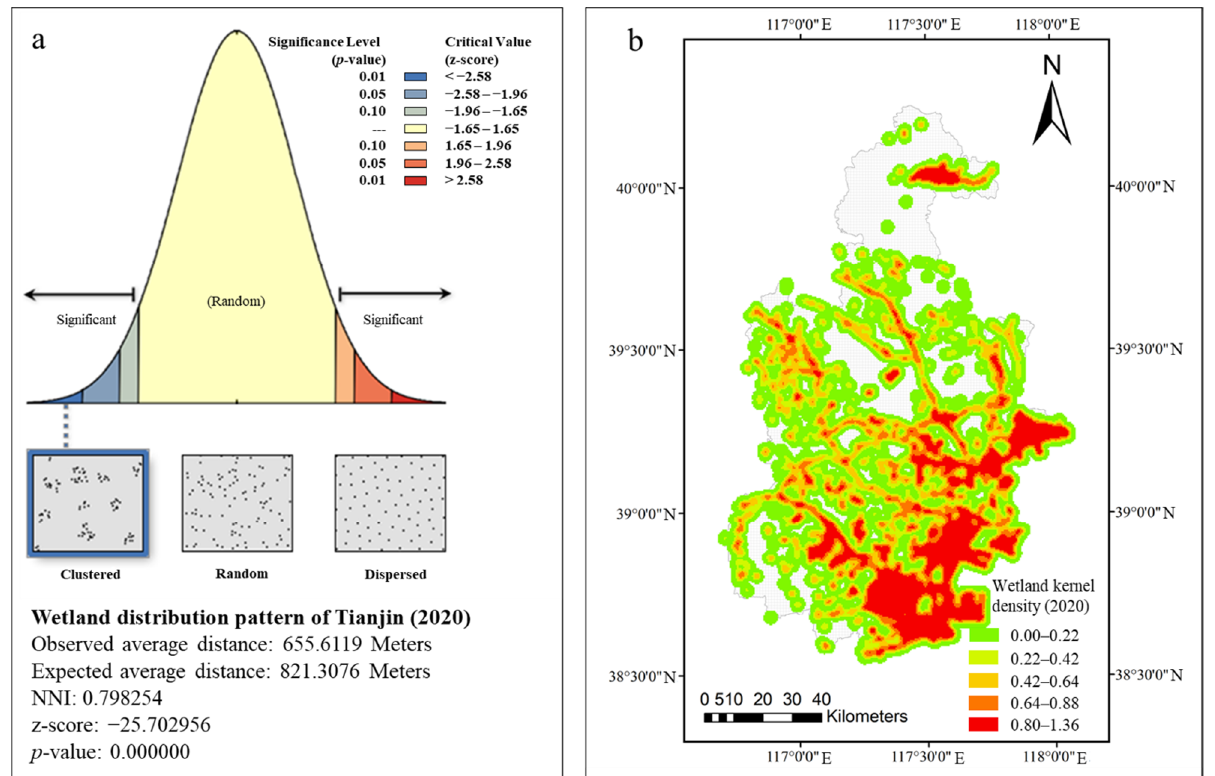
Figure 6. Wetland distribution pattern of Tianjin (2020) ( a ), wetland kernel density of Tianjin (2020) ( b ) .